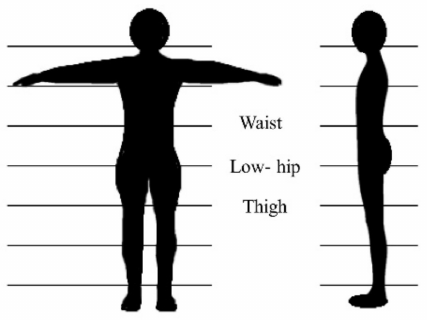
Figure 7. Human body ratio (The waist, lower hip, and thigh areas are